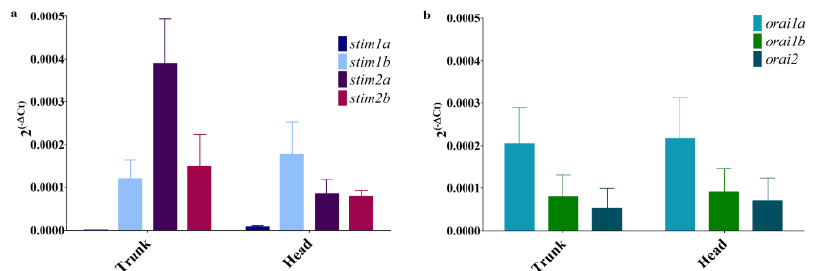
Figure 3. The mRNA levels of stim s ( a ) and orais ( b ) in zebrafish larval heads and trunks, estimated by RT-PCR: The data are presented as expression levels ± SD, calculated using the 2 ( −ΔCq) method normalized to eef1a1l1 ( n = 3 – 4).